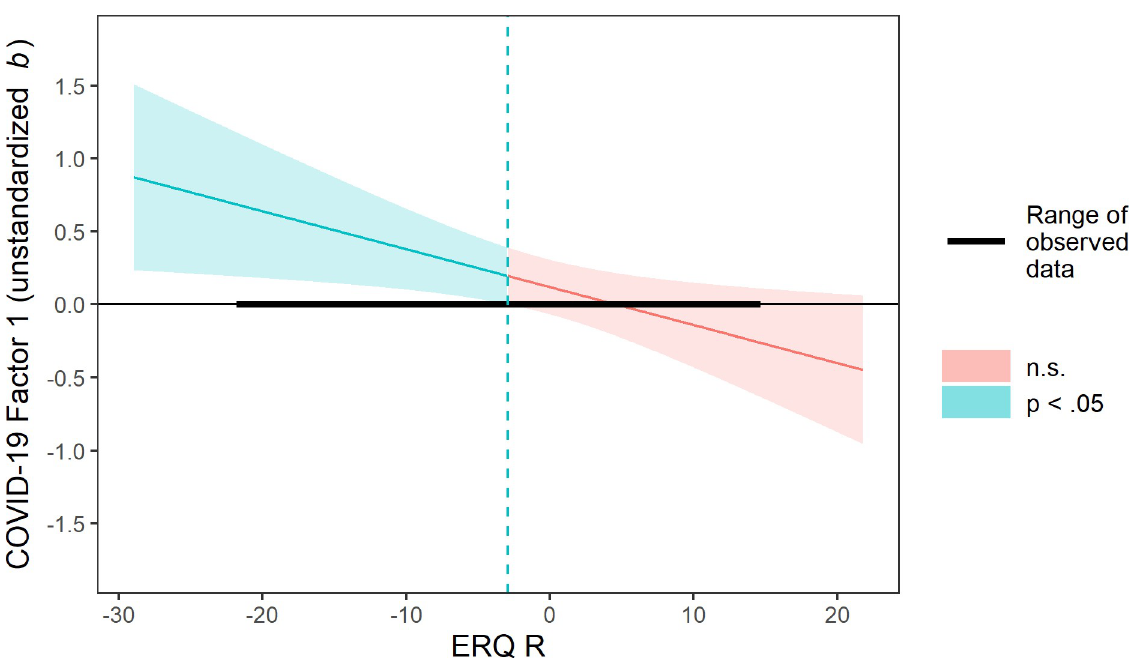
Fig 1. Conditional effect plot for the interactive effect of COVID-19 impact Factor 1 (social life, free time activities, physical activity) and reappraisal on reported satisfaction with life. Note . COVID-19 impact Factor 1 and ERQ reappraisal scores have been mean centered on this plot and in the corresponding regression